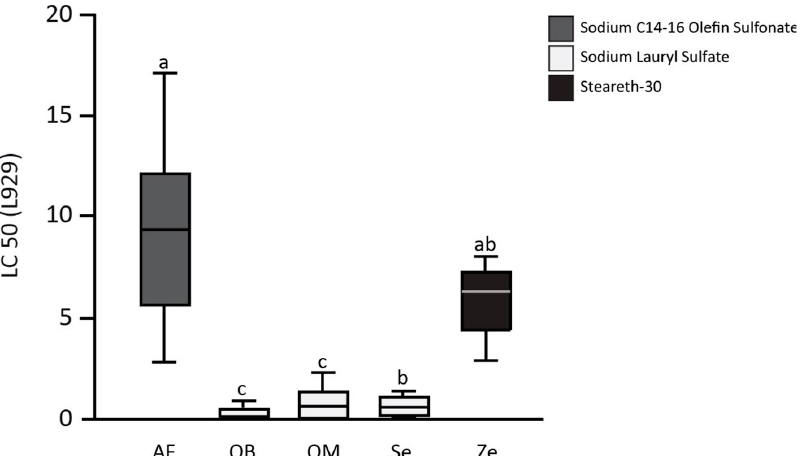
Figure 1. The half lethal concentration (LC50) of toothpaste ‐ conditioned medium (TCM) of the toothpastes (one experimental toothpaste, AirFlow AF, and four commercially available toothpastes, Zendium Ze, Sensodyne Se, OdolMed OM, and OralB OB) on L929 cells. The different letters indicate statistically significant differences.